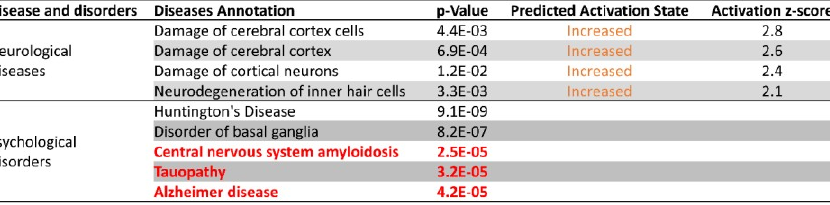
Figure 12. Arc and neurological disorders . Prevention of activity-dependent expression of Arc resulted in gene expression profile changes that are associated with neurological diseases and psychological disorders, including Huntington’s and Alzheimer’s disease, CNS amyloidosis and Tauopathy.